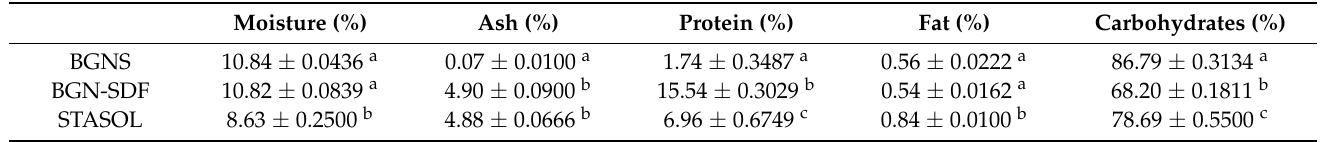
Table 2. Chemical composition of BGNS, BGN-SDF and STASOL. Moisture (%) Carbohydrates (%)